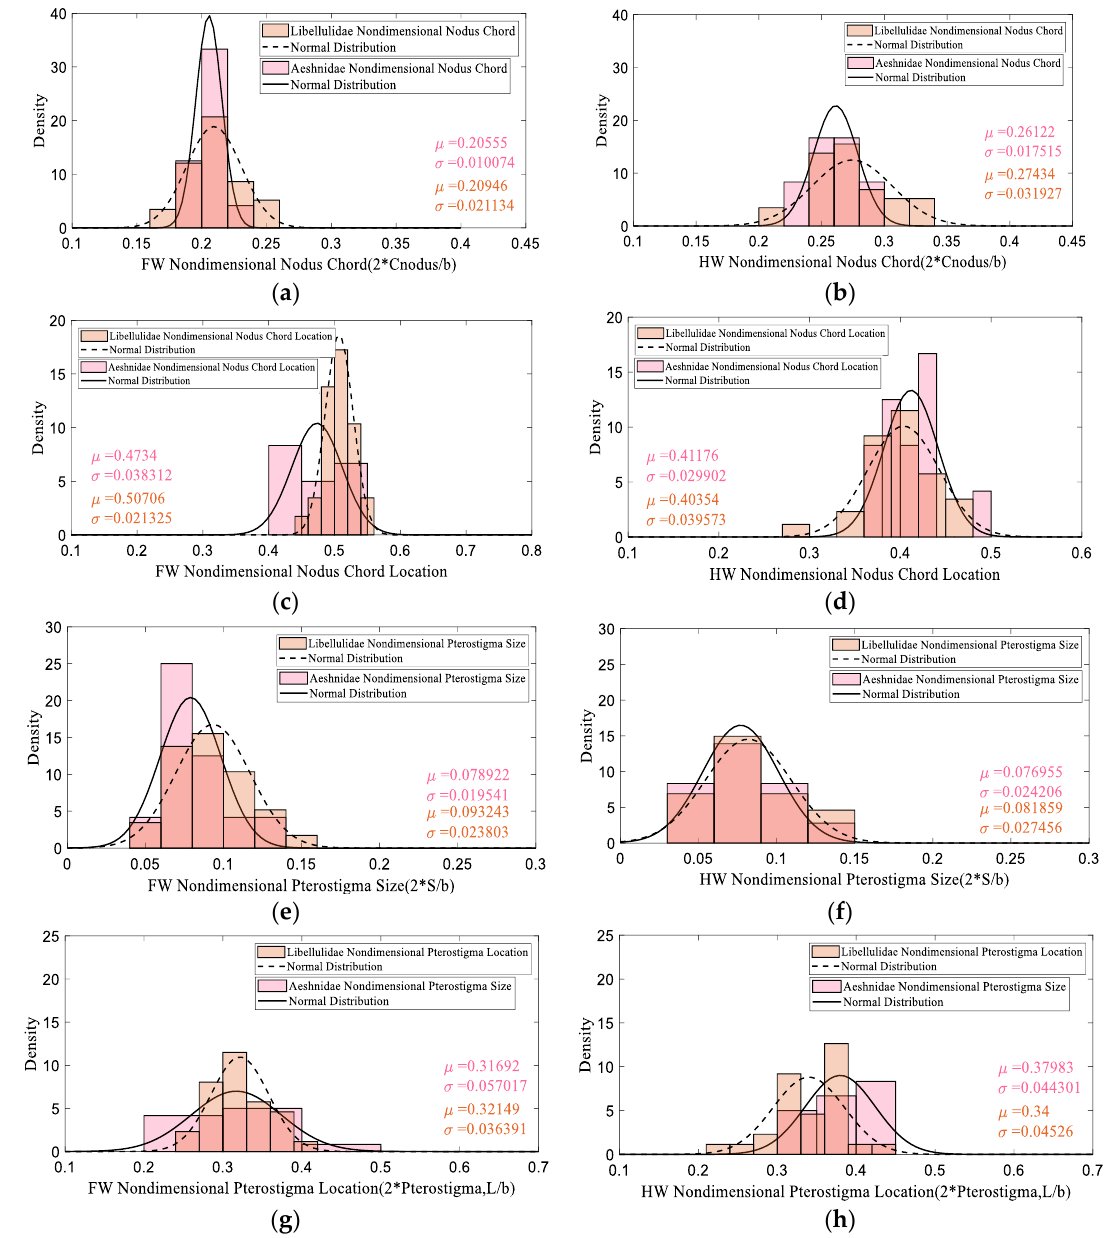
Figure 9. Probability density function and fitted normal distribution of non-dimensional parameters: FW nodus chord ( a ), HW nodus chord ( b ), FW nodus chord location ( c ), HW nodus chord location ( d ), FW pterostigma size ( e ), HW pterostigma size ( f ), FW pterostigma location ( g ) and HW pterostigma location ( h ) for both FW and HW of two families of Aeshnidae and Libellulidae.